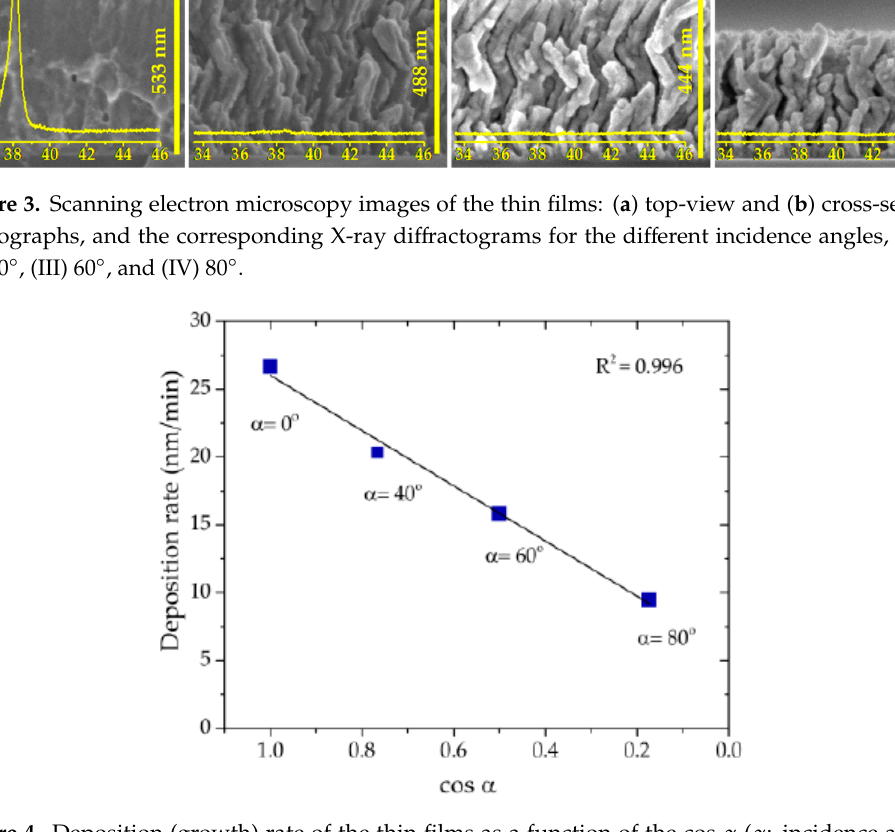
Figure 4. Deposition (growth) rate of the thin films as a function of the cos α ( α : incidence angle), following the cosine law